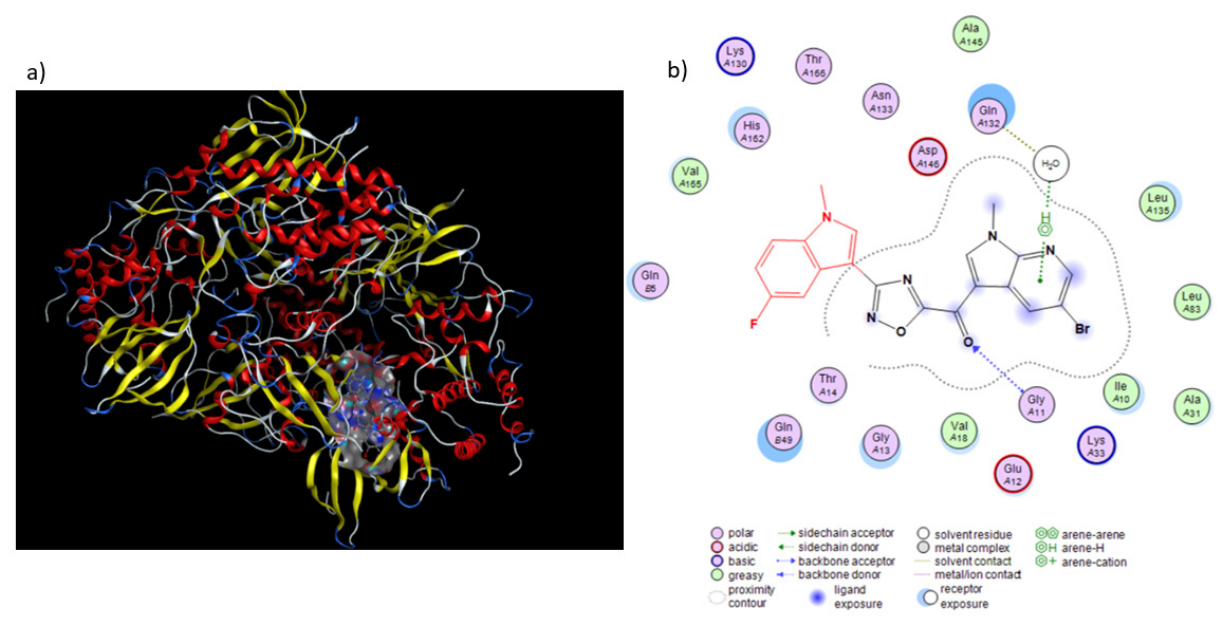
Figure 4. Proposed binding mode of compounds 6b with CDK1 (PDB ID: 4YC6). ( a ) Surface representation of 6b in CDK1 binding pocket. ( b ) H-bonds between the carbonyl group of our compound with the peptide nitrogen of Gly11 residue is shown with blue dashed arrow, while the water-mediated interaction between the nitrogen atom of the 7-azaindole portion adjacent to the oxadiazole ring and the Gln132 residue is depicted with green dashed lines. Table 3. ADME predictions of compound 6b